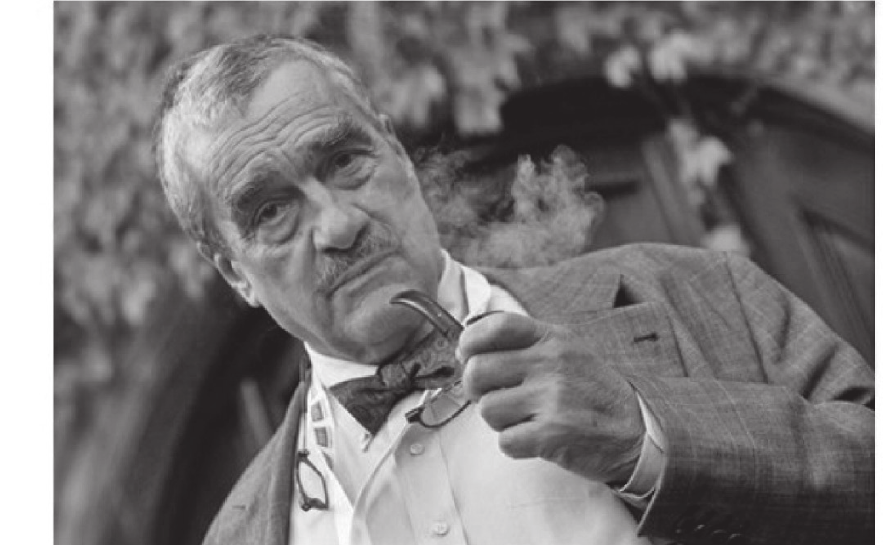
Fig. 2. Karel Schwarzenberg, Lidovky.cz , 13. 1. 2013